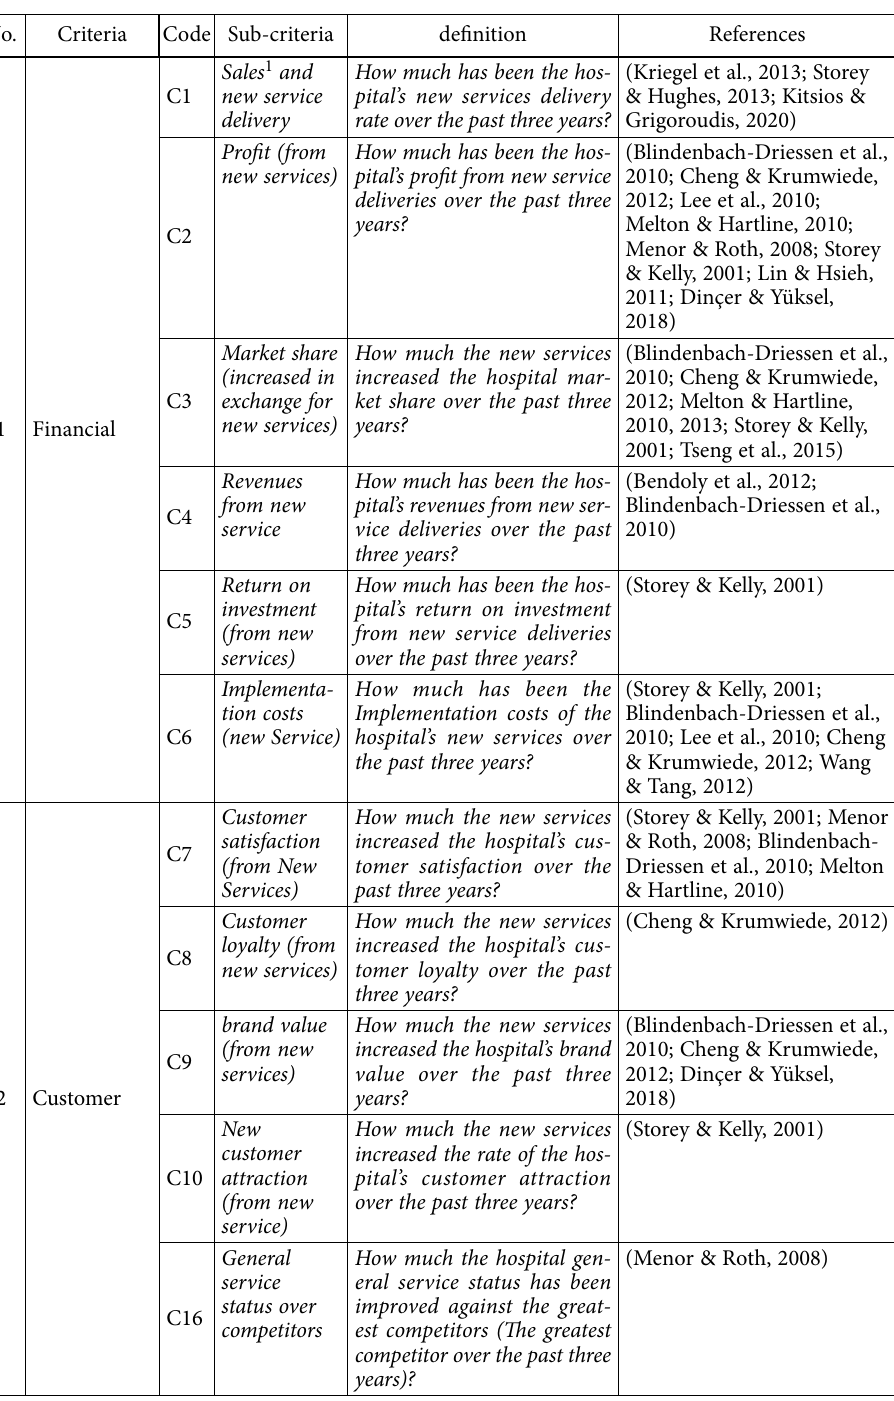
Table 2. List of final criteria